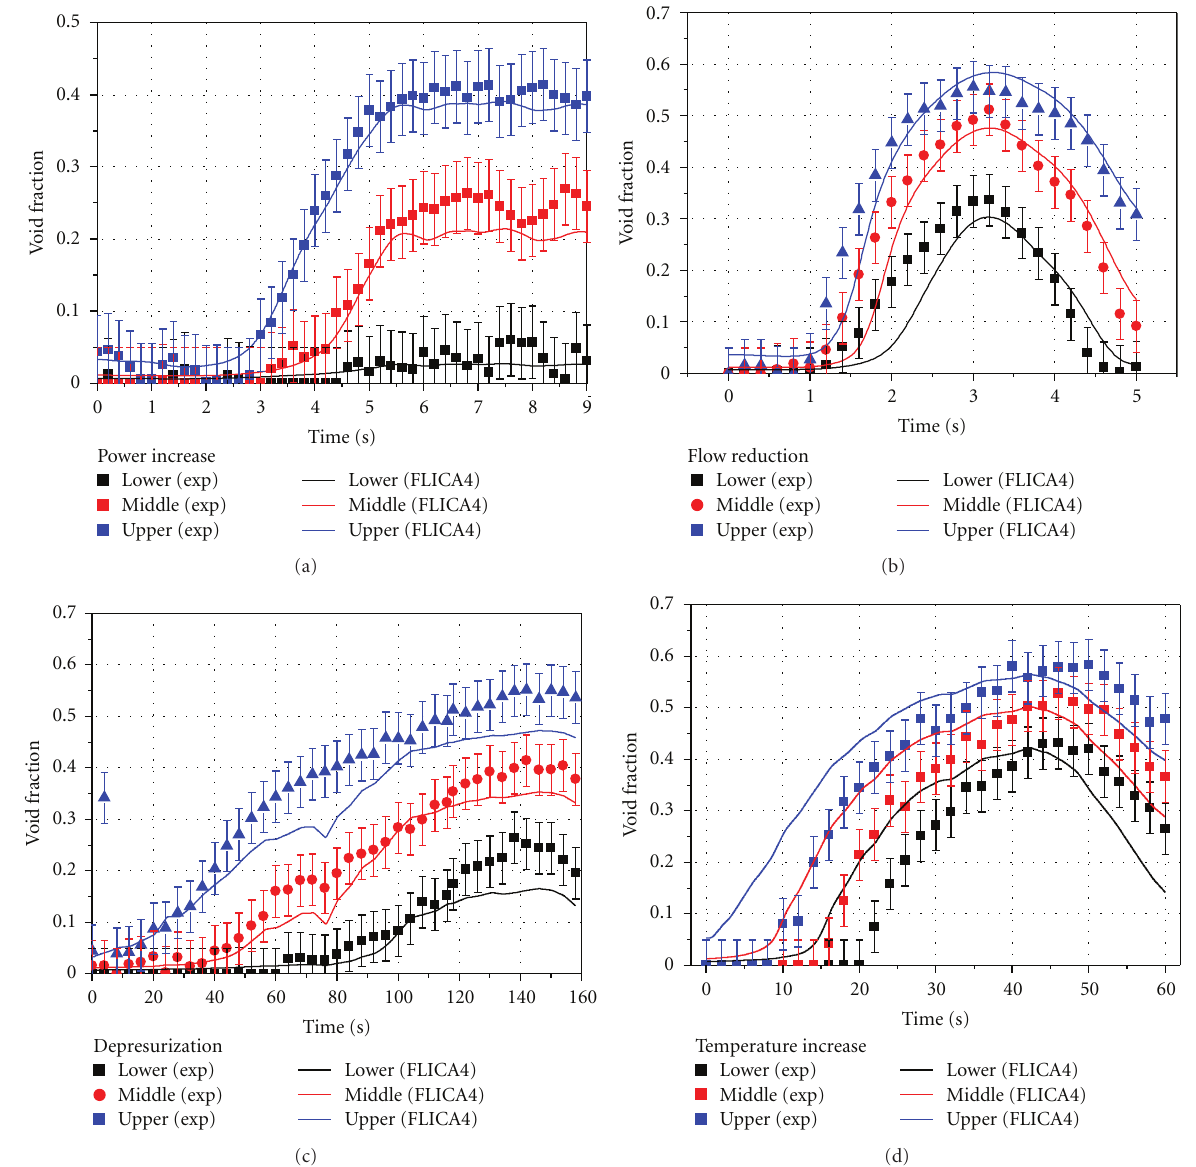
Figure 16: Axial void fraction of transient exercise